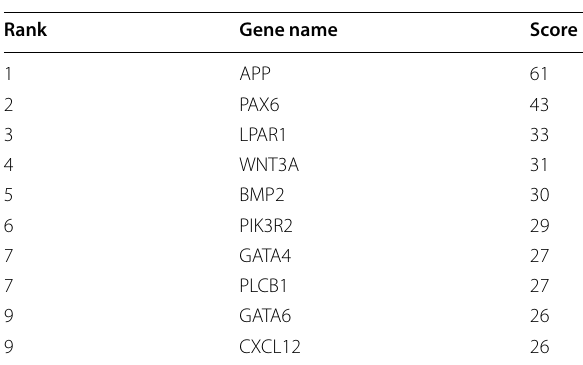
Table 5 Top 10 genes in network string interactions ranked